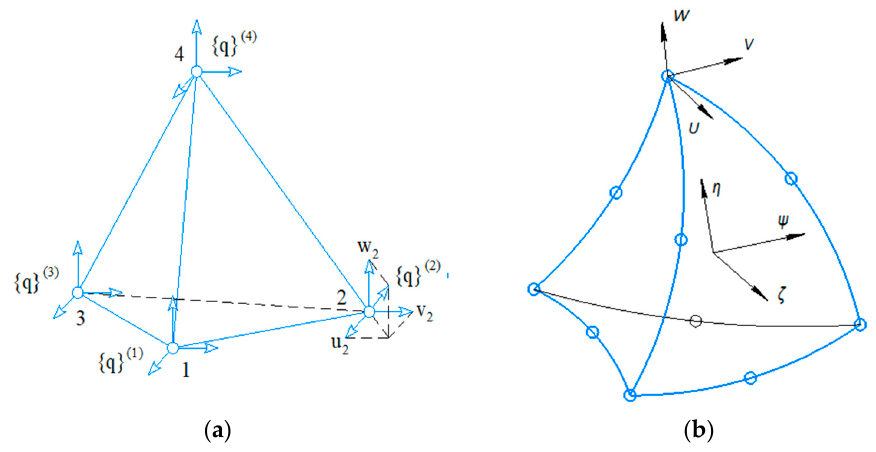
Figure 4. A finite element in the form of a tetrahedron.